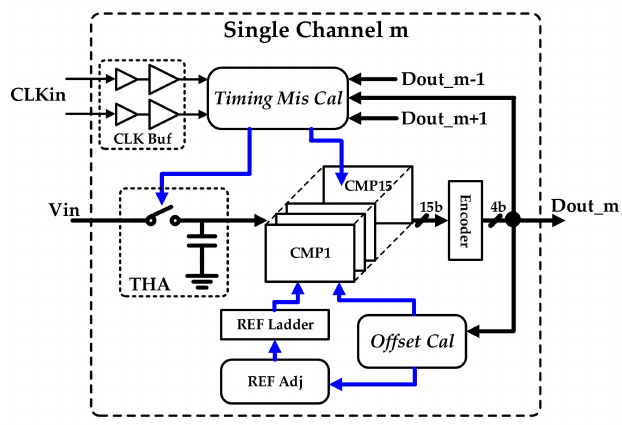
Figure 2. Block diagram of the single-channel